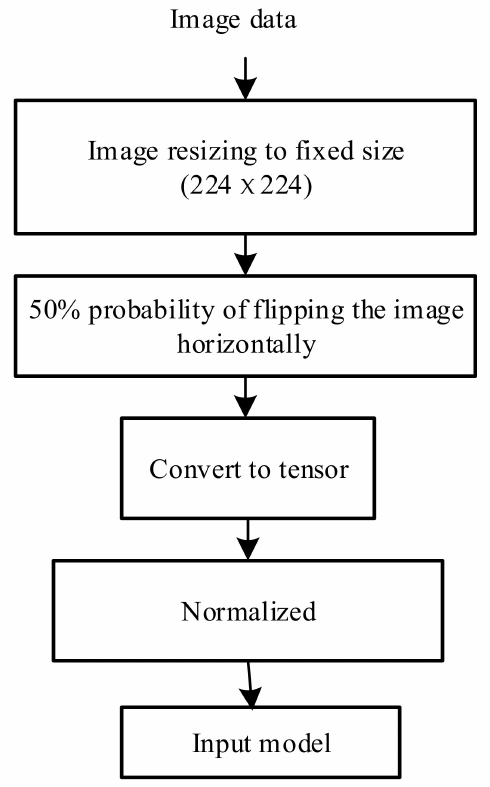
Figure 3. Image pre-processing